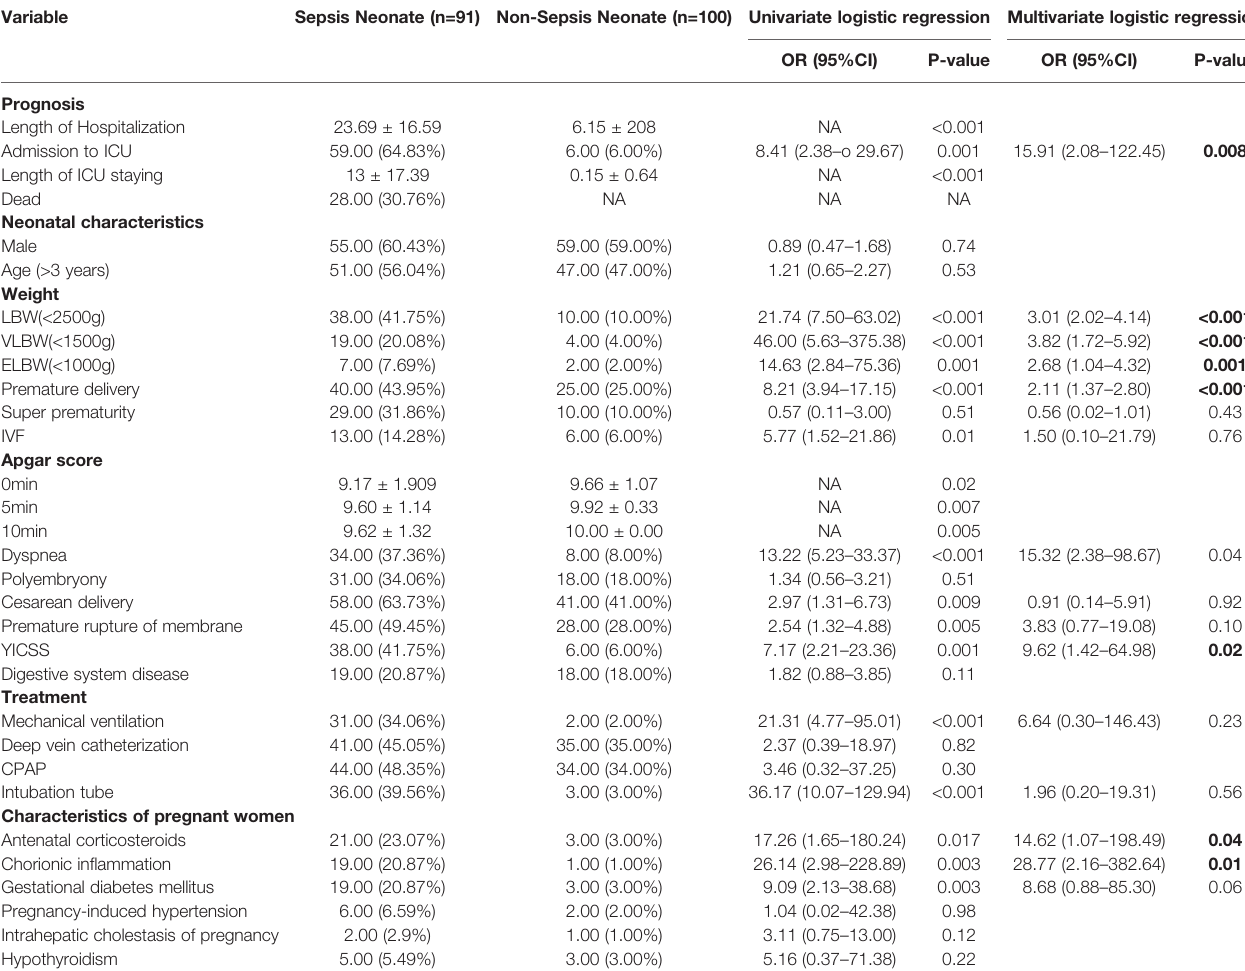
TABLE 6 | Univariate and multivariate analyses of risk factors and outcomes for sepsis neonate compared with non-sepsis neonate from 2017 to 2019. Variable